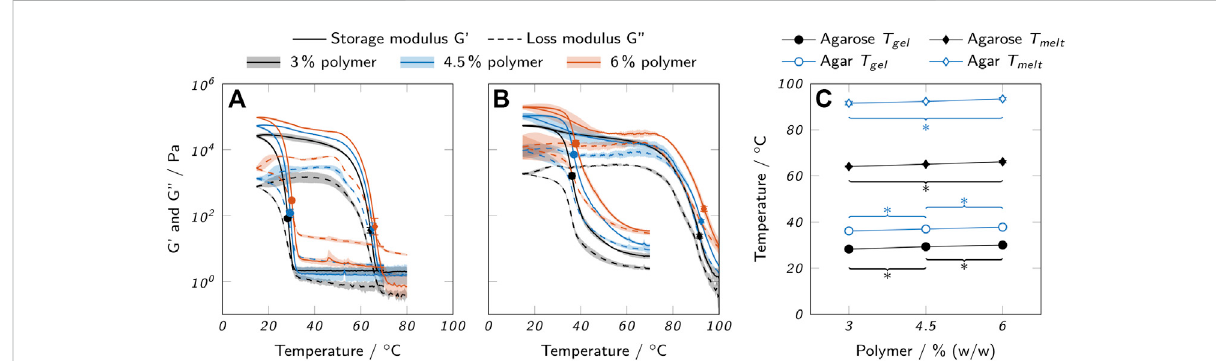
FIGURE 3 Thermal properties of low-melt agarose and agar hydrogels. Loss and storage modulus of (A) low-melt agarose and (B) agar hydrogels are shown over temperature. (C) Melting and gelling points of low-melt agarose and agar, as derived from the oscillatory measurements. All data are shown as mean values with the standard deviation as shaded areas or error bars ( n = 3). For clarity, only signi fi cant differences to the nearest signi fi cantly different data points are highlighted by asterisks ( p <